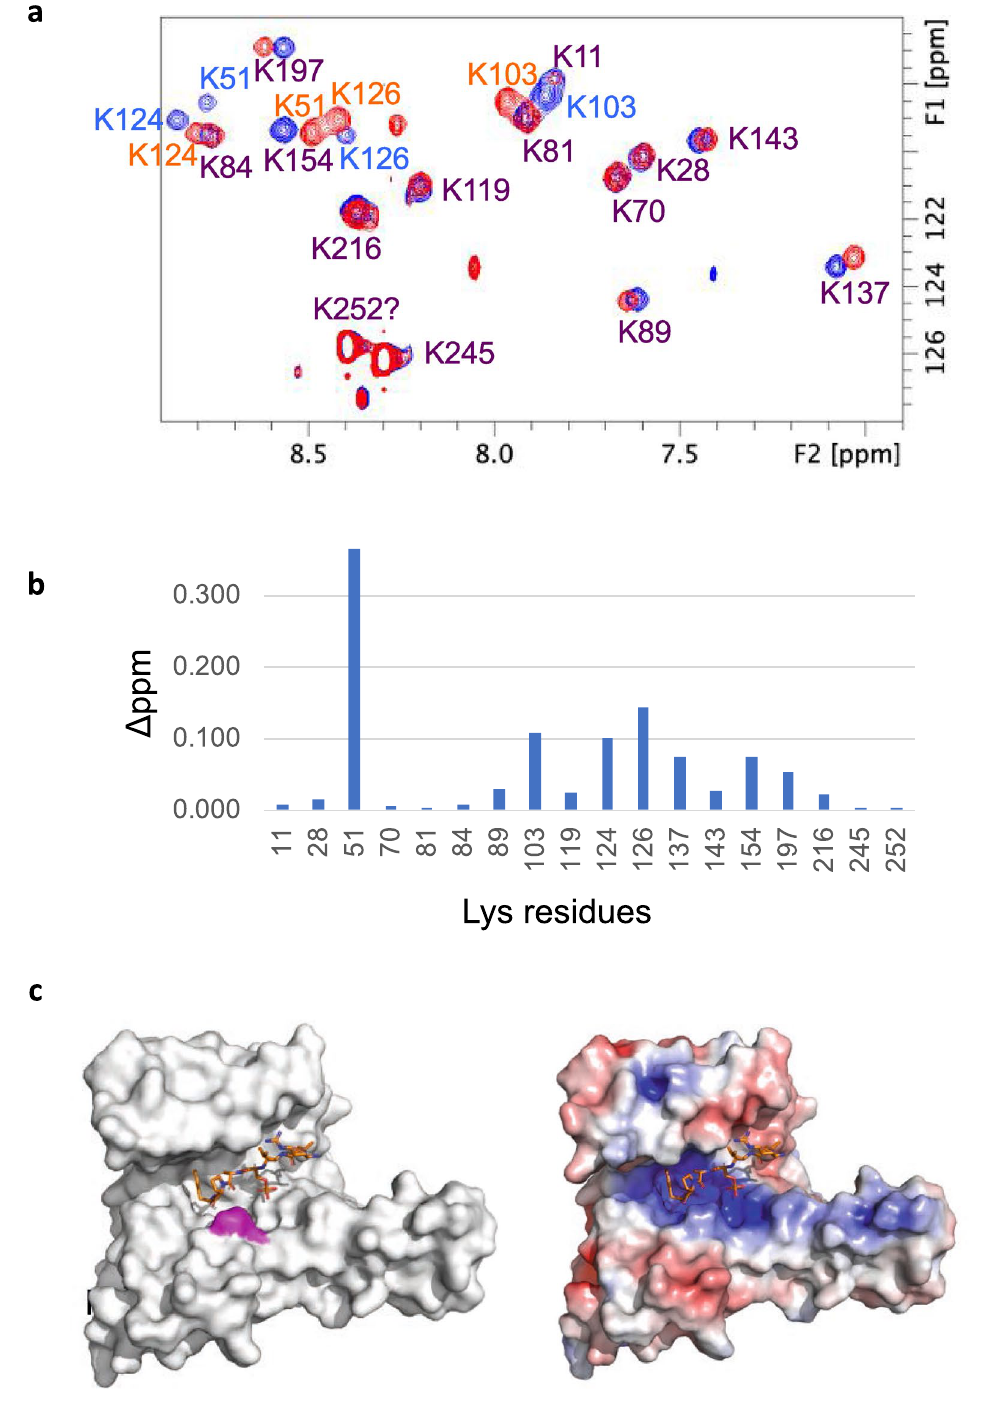
Figure 3. The free and complex forms of St14f in solution could be observed by NMR. ( a ) Overlaid 15 N- 1 H HSQC spectra of 15 N Lys-labeled St14f free form (red) and complex form with StFDL1 peptide (blue). The protein concentration was 250 µM in buffer containing 10 mM Tris, pH 7.5, 1 mM DTT, and 10% D 2 O at 298 K. ( b ) Chemical shift changes of St14f in the presence of 0 mM and 1 mM of StFDL1 peptide are represented by a bar graph. ( c ) Mapping of the affected residues on the St14f surface (left) and electrostatic surface potential calculated using APBS, where red and blue correspond to negative and positive electrostatic potentials, respectively (right). The OsFD1 peptide derived from PDBID 3axy is represented by sticks as the model of the StFDL1 peptide. K51 residues with chemical shift changes of > 0.3 are colored magenta. Figures are prepared by TopSpin 3.6 (https:// www. bruker. com/ en/ produ cts- and- solut ions/ mr/ nmr- softw are/ topsp in. html) and PyMol 2.6 (http:// www. pymol. org/ pymol) 42